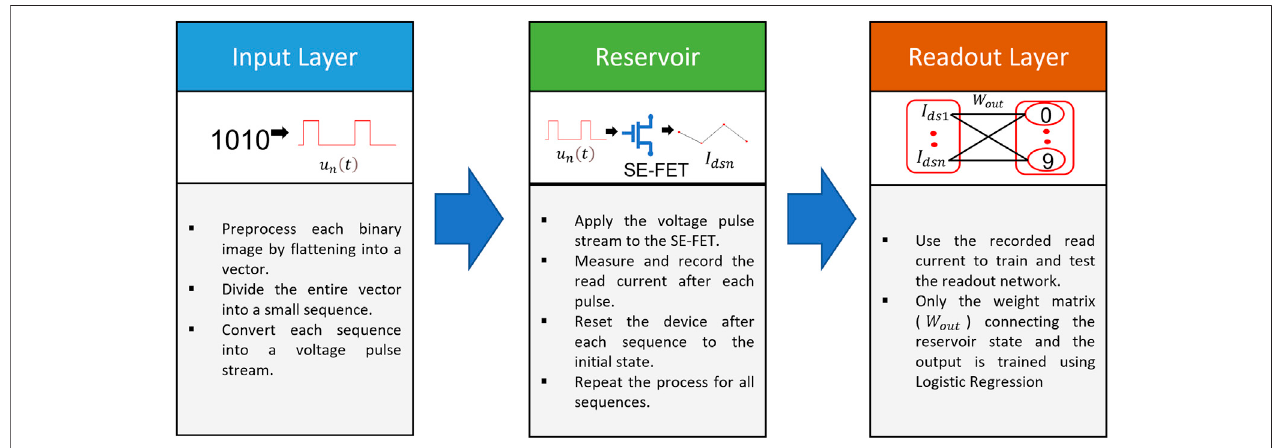
FIGURE 1 | Framework and process fl ow of dynamic SE-FET-based reservoir